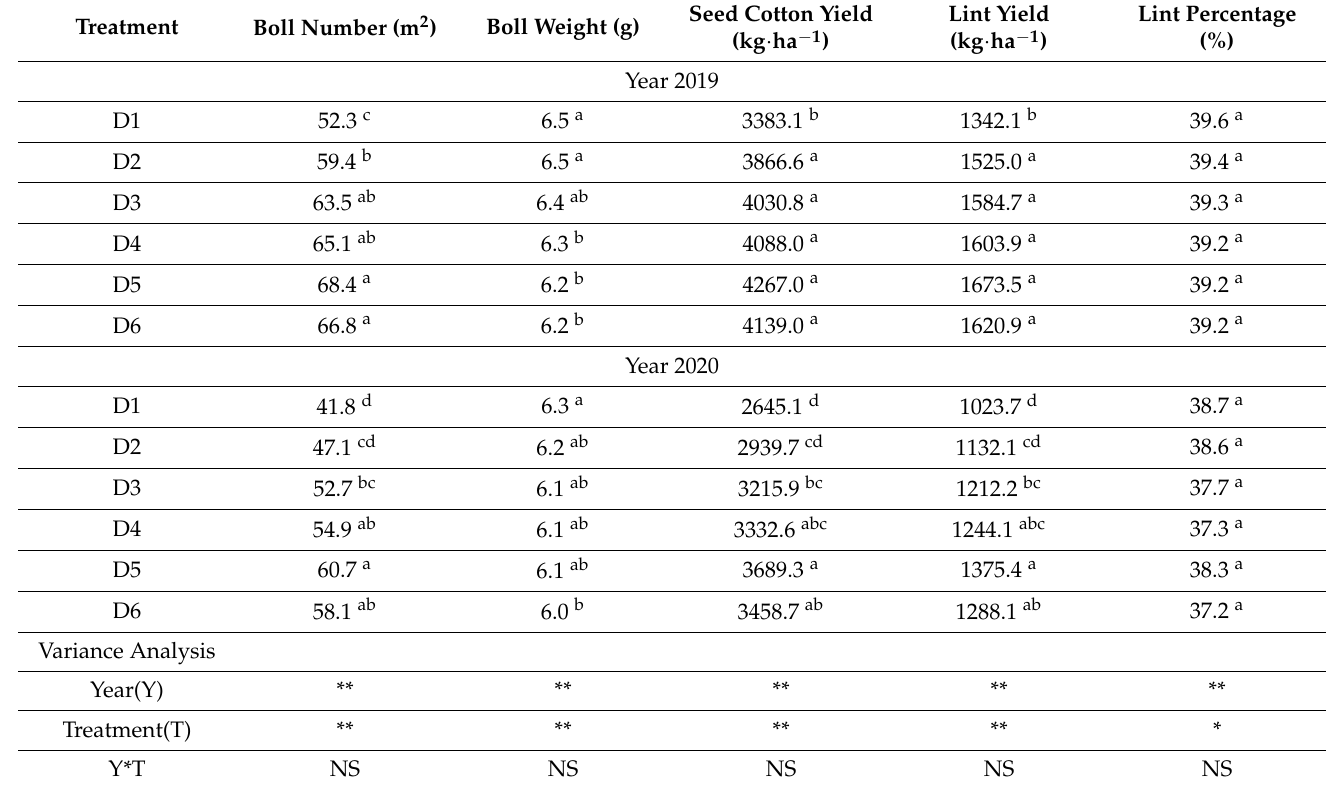
Table 4. Cotton yield and yield components during the cotton growing season in 2019 and 2020.